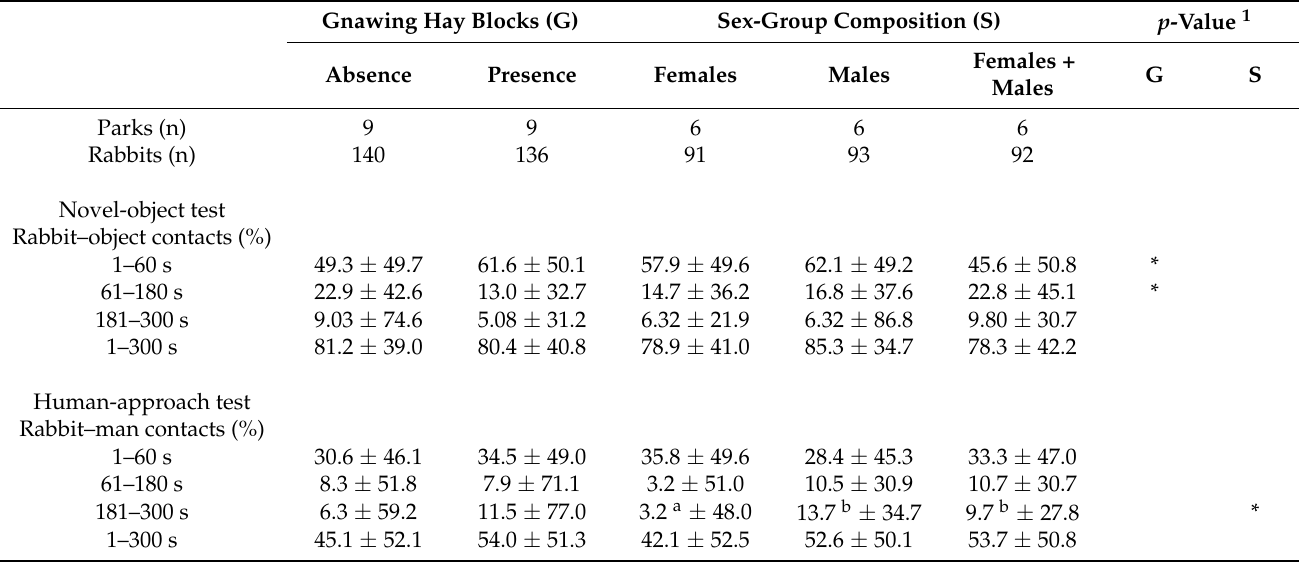
Table 4. Effect of the presence of gnawing hay blocks and sex-group composition on the rabbit–object contacts (rabbits that touched the object, % present rabbits) during the novel-object test at 65 days of age and on the rabbit–man contacts (rabbits that touched the man, % present rabbits) during the human-approach test at 67 days in growing rabbits kept in collective parks. Data are reported as the means ± standard deviations. Gnawing Hay Blocks (G) Sex-Group Composition (S) p -Value 1 Females + G S Absence Presence Females Males Males 9 9 6 6 6 136 91 93